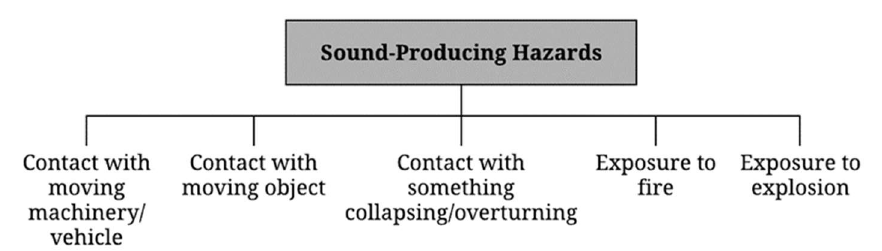
Figure 2. Construction hazards detected by acoustic signals.